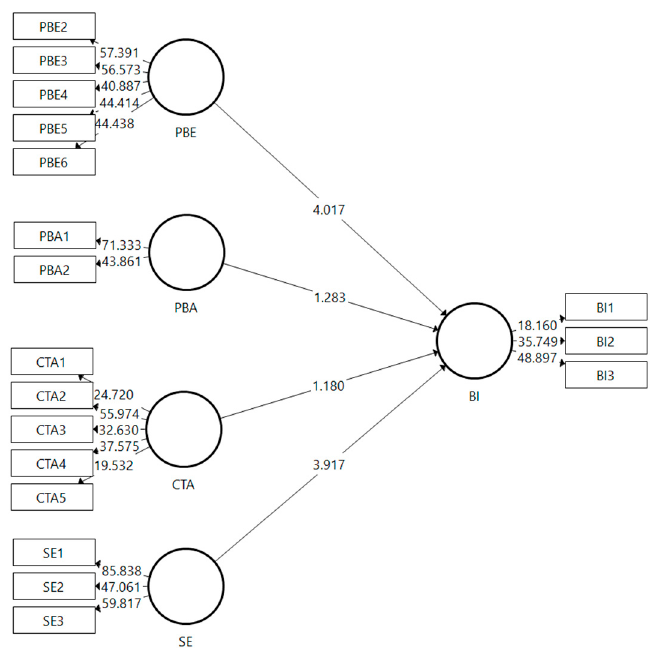
Figure 2. Bootstrapping.